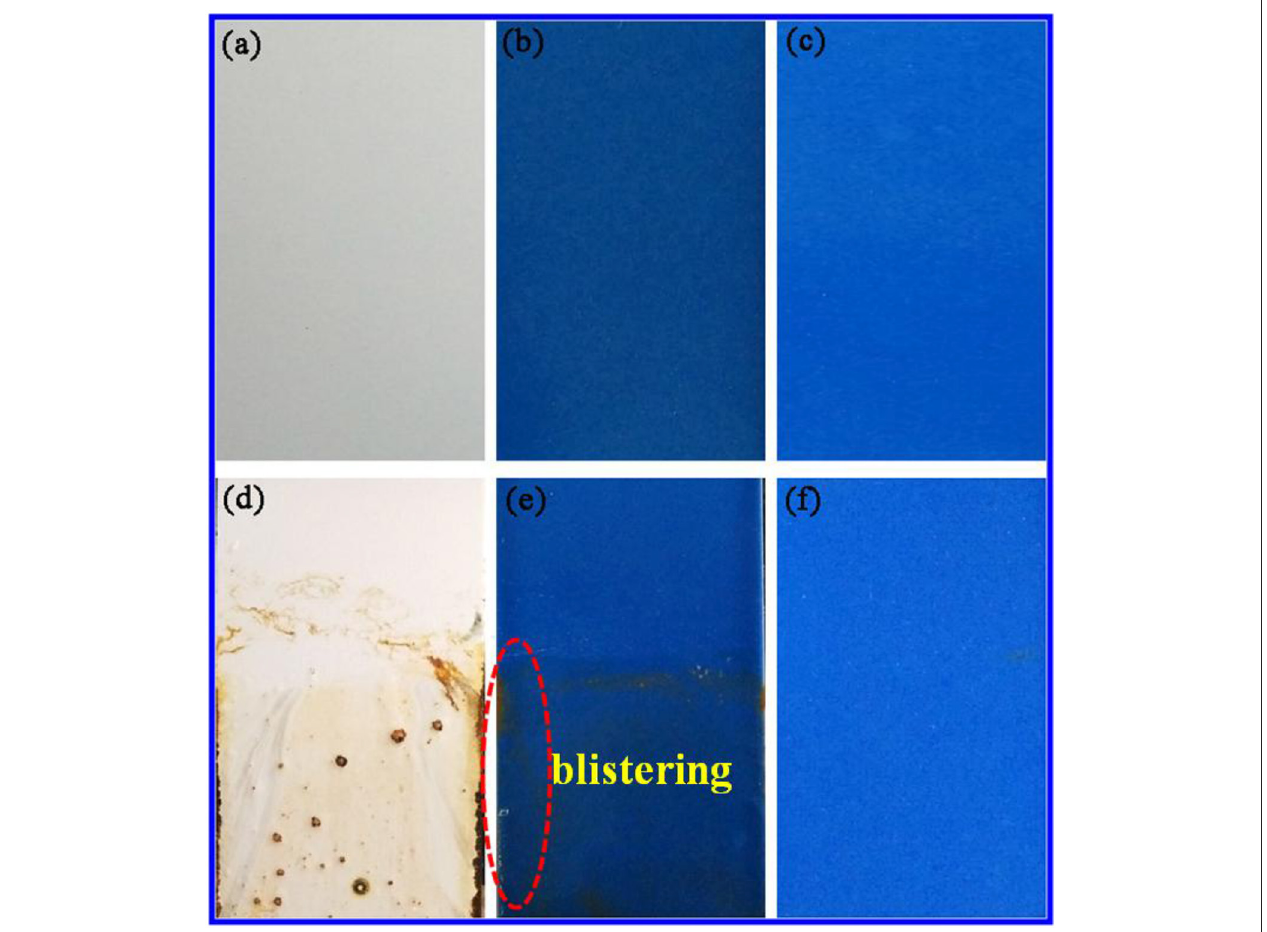
FIGURE 6 | Photographs of the film (a) without pigment, (b) containing CoAl 2 O 4 , and (c) hybrid pigment. (d–f) Their corresponding images after being exposed to 3.5% NaCl for 60 days, respectively.